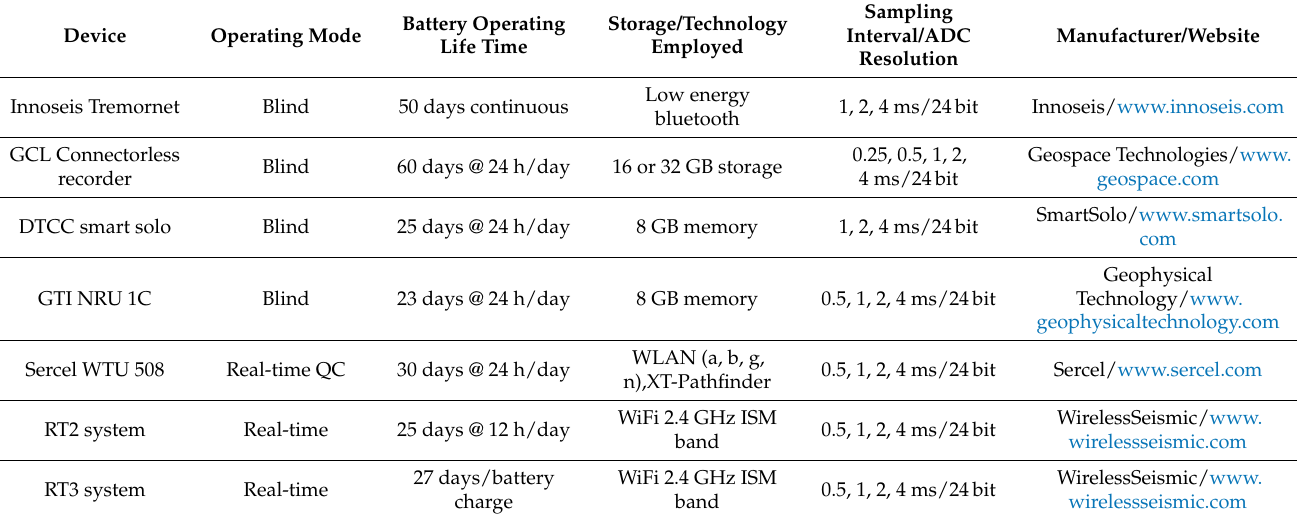
Table 1. Recent nodal seismic units and their